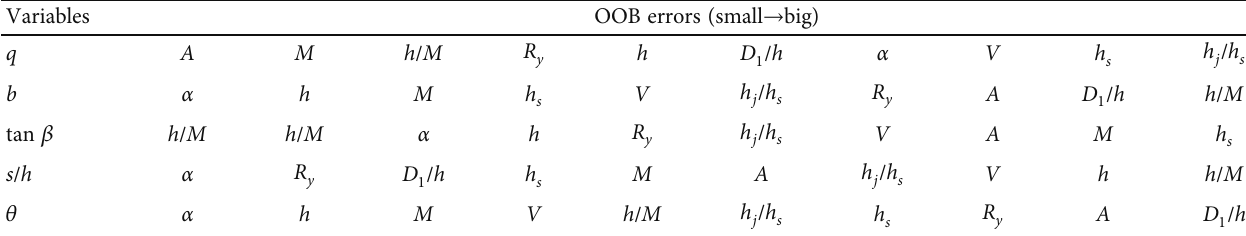
Table 3: Importance of RF feature selection in fl uencing factors.